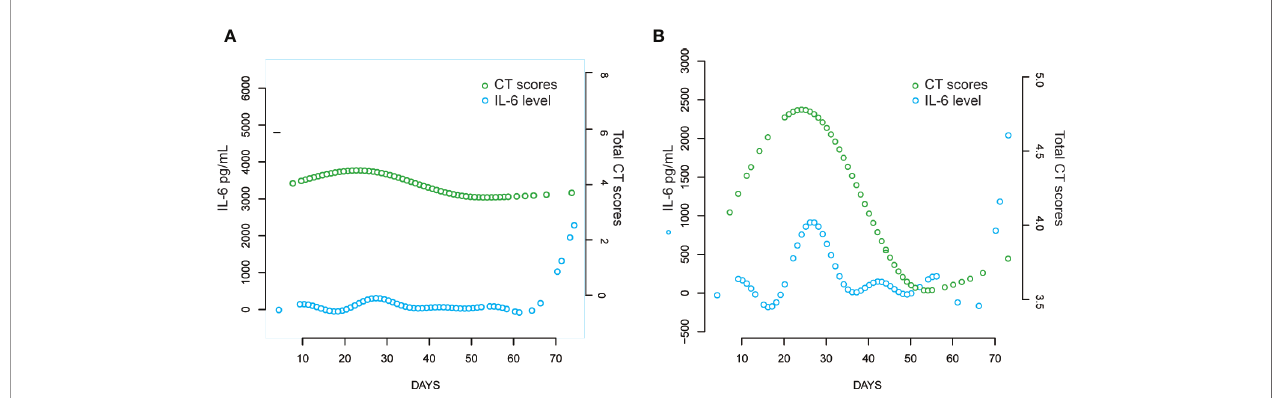
FIGURE 5 | Comparison of CT scores trend and IL-6 levels over time with curve fi tting analyses. (A) All the COVID-19 patients; (B) Patients with